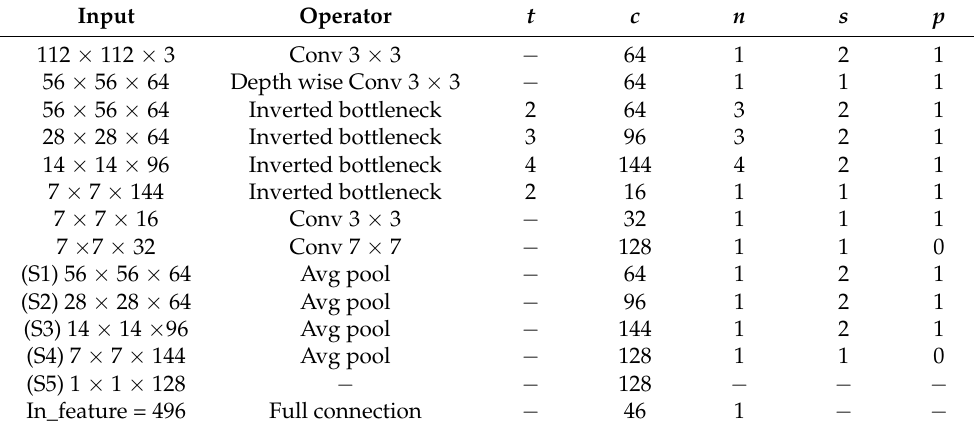
Table 1. MSFLD network